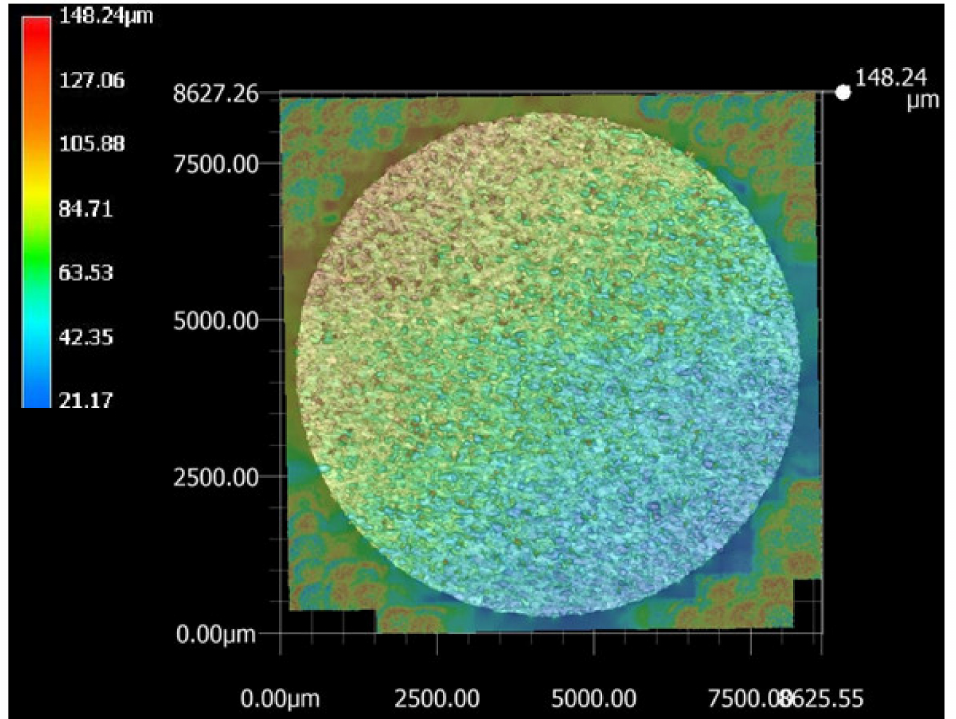
Figure 2. Top surface 3-D profie representing SR